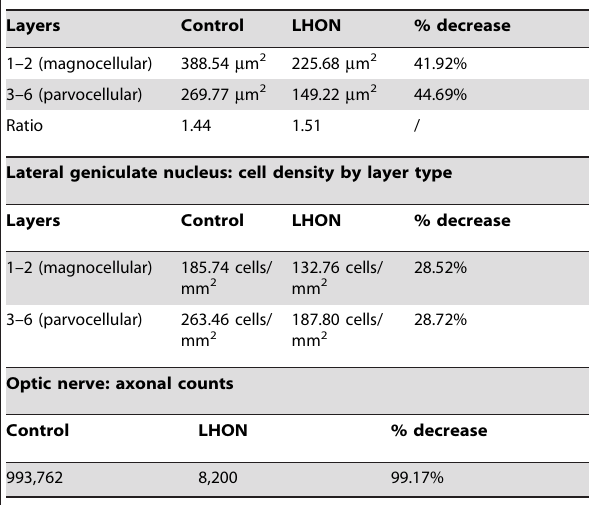
The ratio of the magnocellular to parvocellular layers for the two LGN is similar suggesting that the atrophy seen in the LHON case was consistent across all layers. Middle: average cell density of the magnocellular and parvocellular layers for both the LHON and control LGNs. LHON LGN exhibits a decrease in neuron density consistent across both cell layer types. Bottom: axonal counts for LHON and control left optic